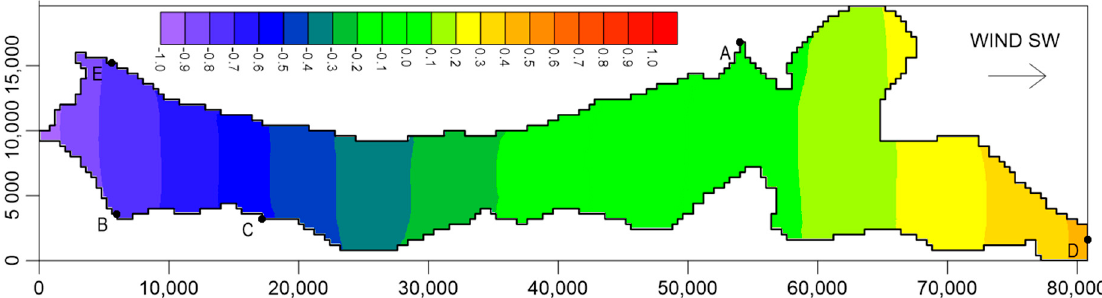
Figure 10. Water flow velocity (m s -1 ) after 12 hours of a NE wind at a speed of 12 m s -1 and with the new artificial strait at point E (dimensions in meters).